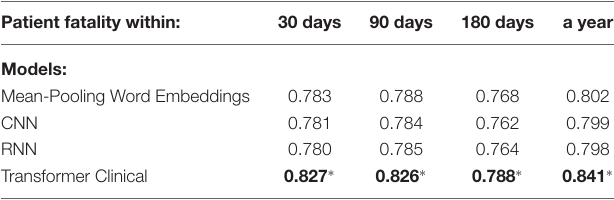
TABLE 13 | Combining the transformer-model with non-text attributes for the re-admission prediction targets.